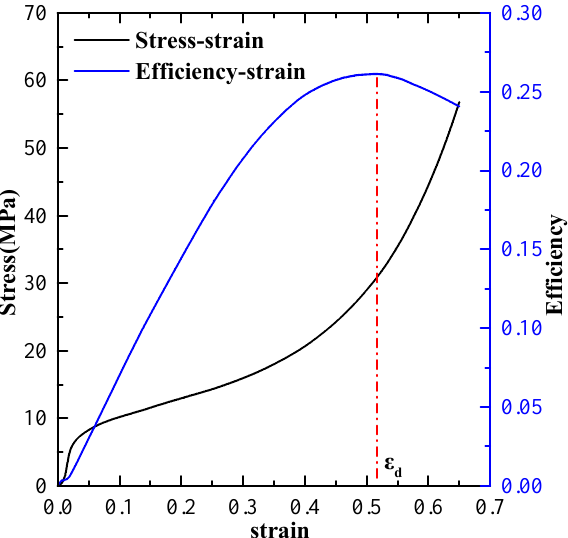
The above presented methods are utilized to calculate the densification strain, the plateau stress and the densification strain energy here, respectively.